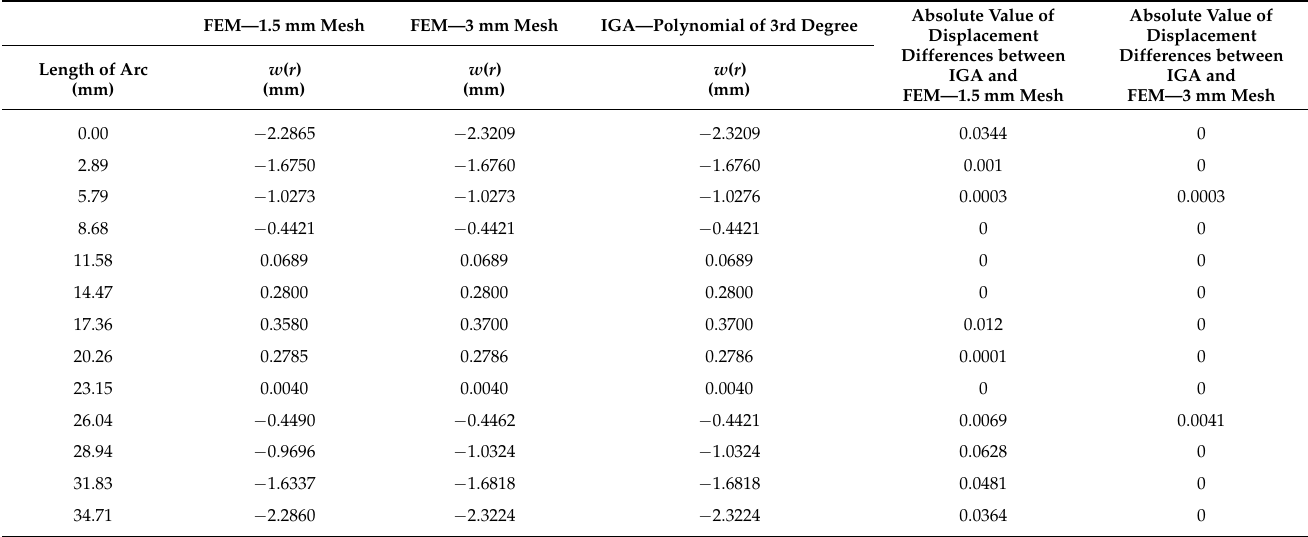
Figure 12. Comparison of displacements in the z -axis direction. Table 3. Computed displacements of the points for the different solution methods.